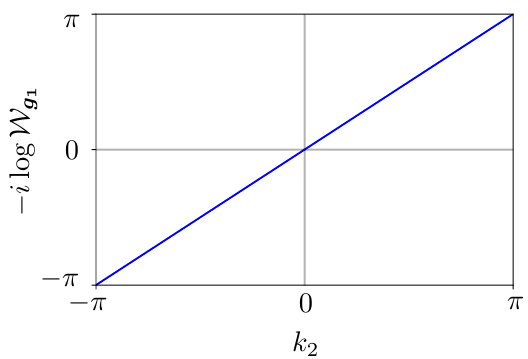
Figure 12: Wilson loop eigenvalue of the valence band in the model for the Thouless pump. Notice that, as was explained in detail in Sec. 5.1, inversion symmetry requires = the spectrum to be antisymmetric about k 2